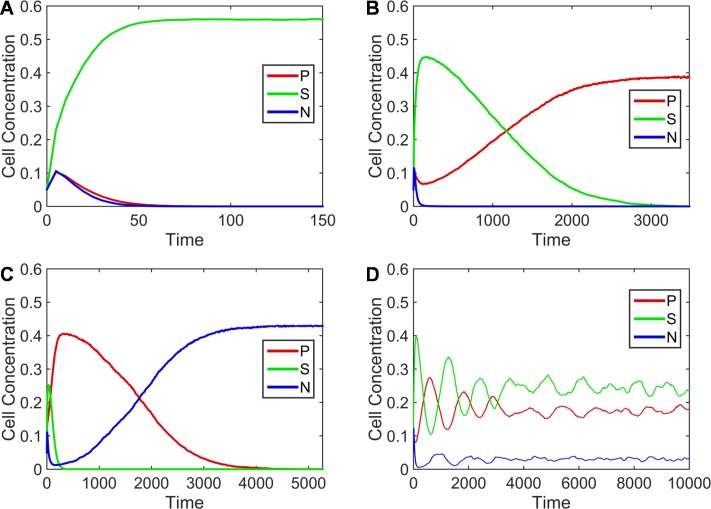
Cell concentrations as a function of time in different runs of the lattice model.Each run begins with randomly positioned P, N and S cells with a concentration of 0.05 each. For all examples r1 = 2, r2 = 2.5, b = 10 and the lattice size is 1024×1024. The other parameters differ. A) Sensitive cells win when c = 0.0011 and a = 30. B) Producers win when c = 0.0011 and a = 100. C) Non-producers win when c = 0.0002 and a = 90. D) The three cell types coexist when c = 0.001 and a = 150.